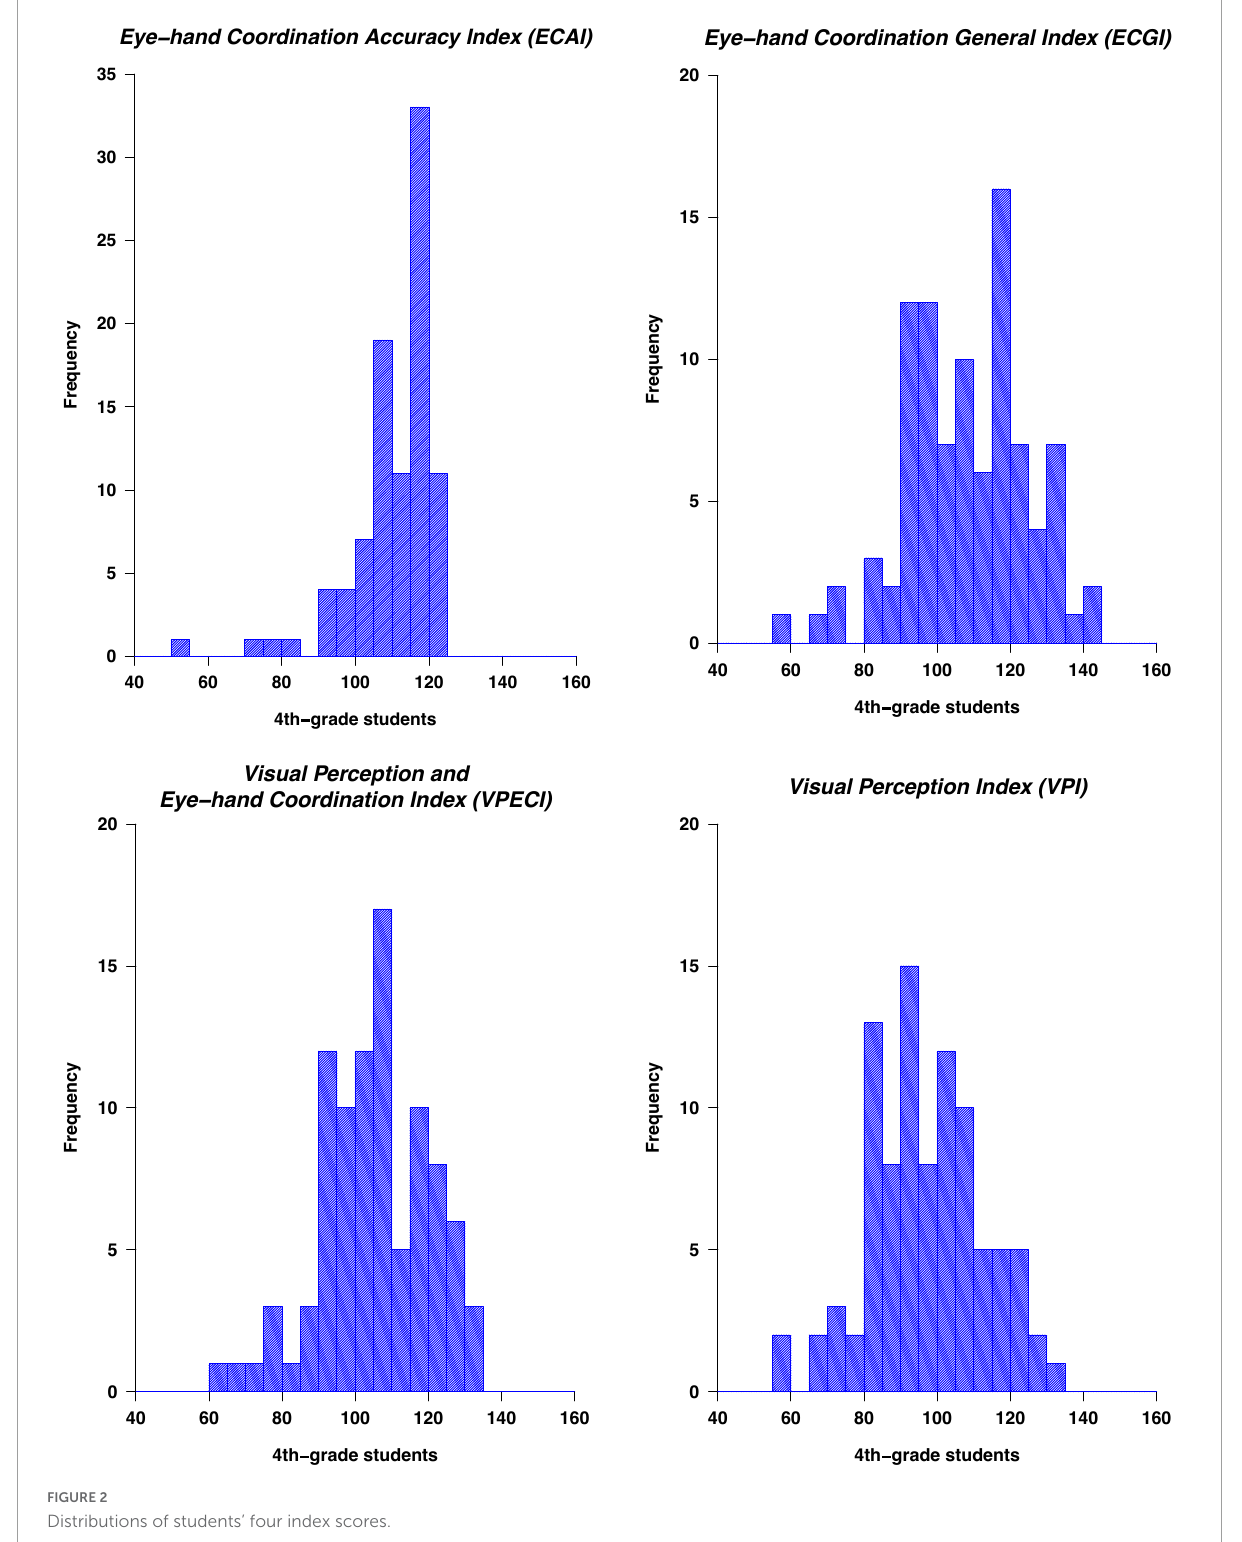
FIGURE2 Distributions of students’ four index